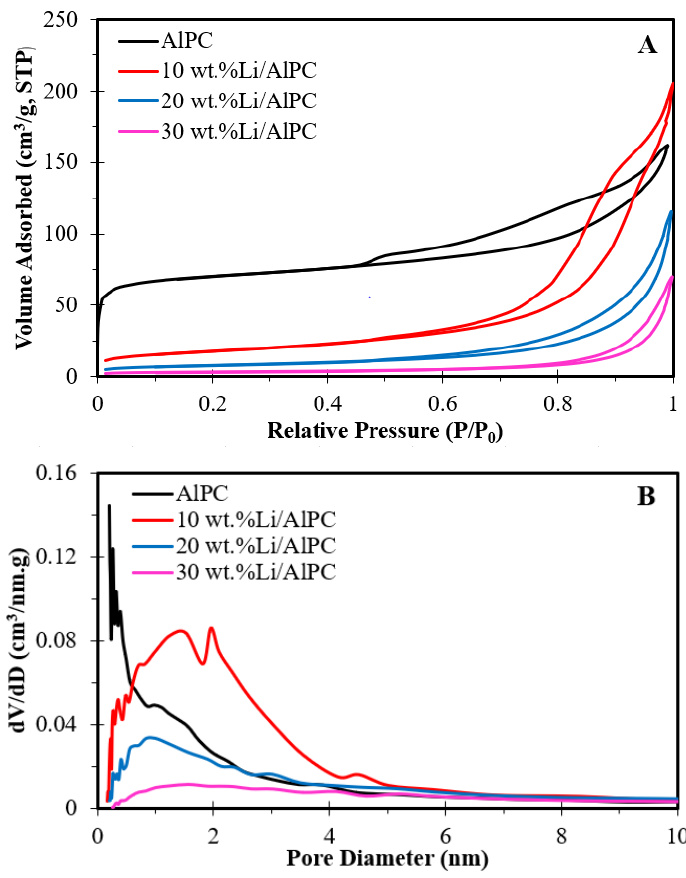
Figure 2. ( A ) Nitrogen adsorption–desorption isotherms and ( B ) pore size distribution of AlPC and x wt. %Li / AlPC (x = 10, 20 and 30 wt. %)